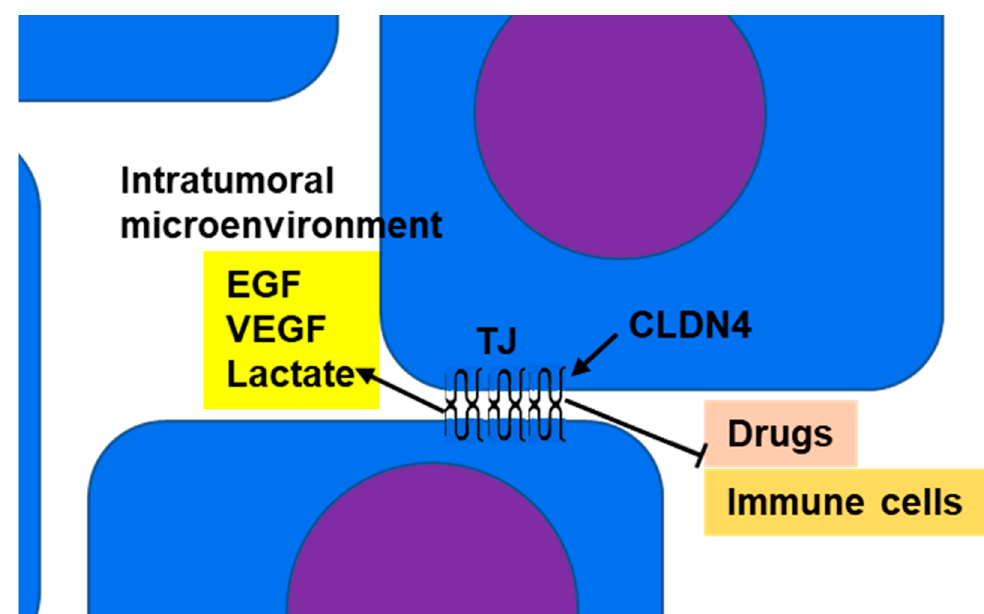
Figure 1. Barrier function of TJs: CLDN4, which is overexpressed in epithelial malignancies, separates the intratumoral microenvironment from the tumor exterior by forming TJs. As a result, growth factors (such as EGF and VEGF) and metabolites (such as lactate) accumulate in the intratumoral microenvironment, resulting in amplification of their effects. This promotes increased tumor grade and suppression of immune cell infiltration into the tumor. TJs also inhibit the penetration of anticancer drugs from the tumor exterior into the microenvironment and enhance resistance to anticancer drugs. CLDN4, claudin-4; TJ, tight junction; EGF, epidermal growth factor; VEGF, vascular endothelial growth factor.